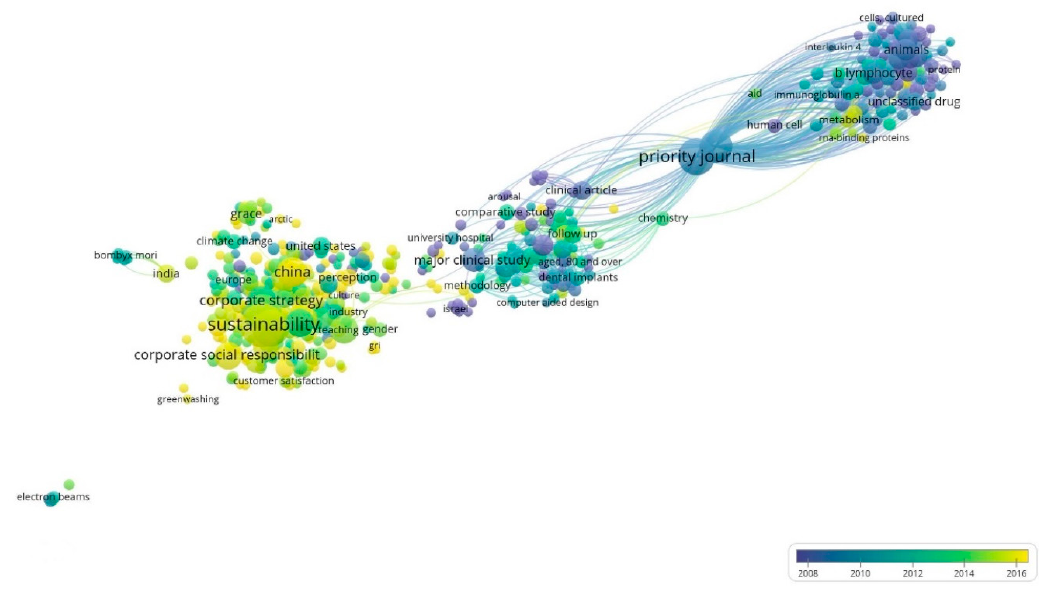
Figure 8. Evolution of keywords network based on co-occurrence (1970–2019).